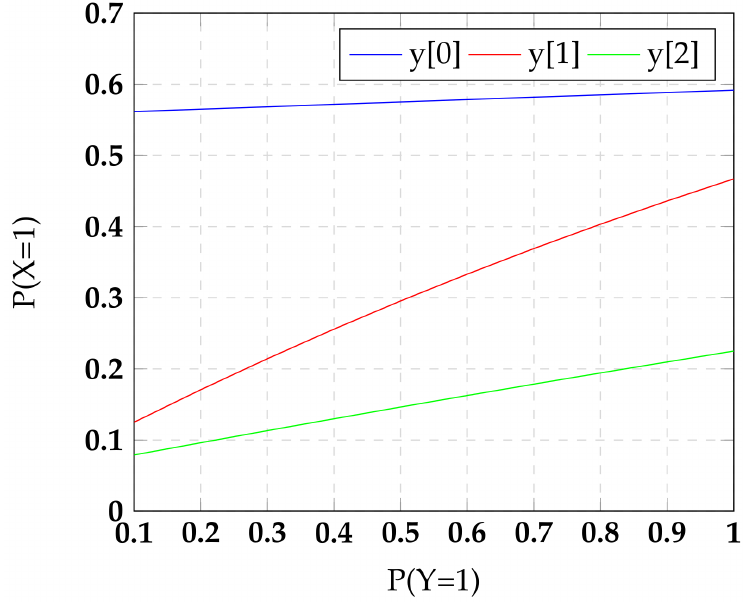
Figure 5. Transition probability of RNS encoding